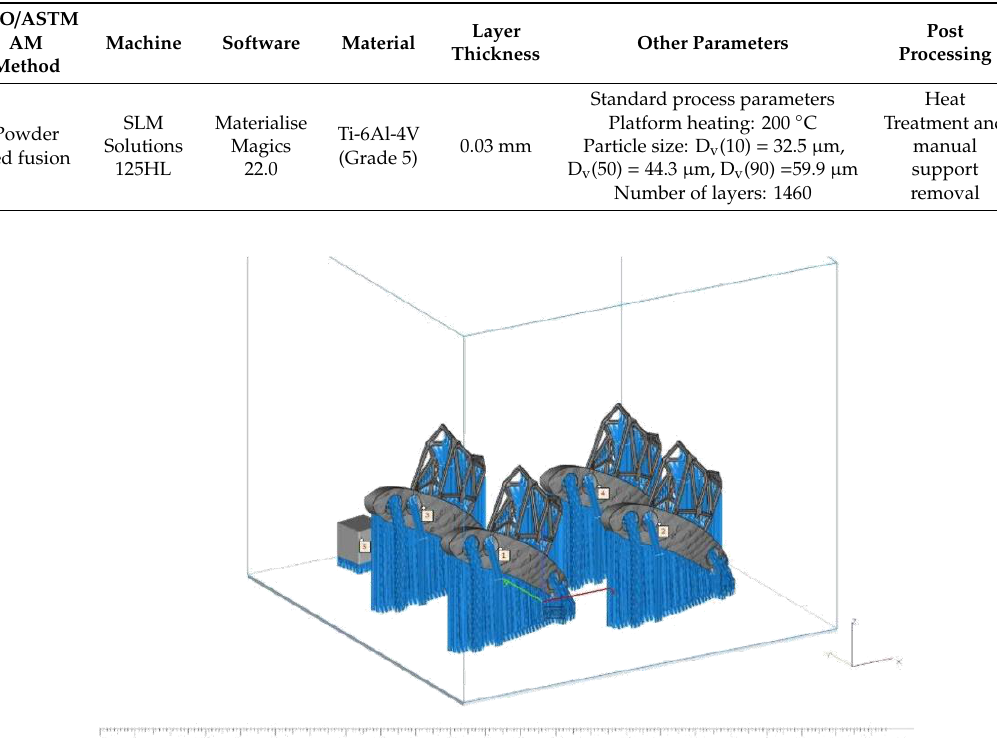
Table 3. Additive manufacturing (AM) parameters for the end-use implant.